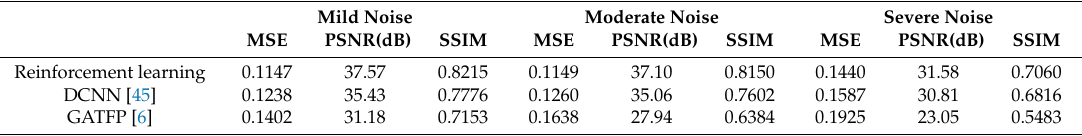
Table 1. Arithmetic means of evaluation indicators for all the testing images with three levels of noise using three di ff erent denoising methods.